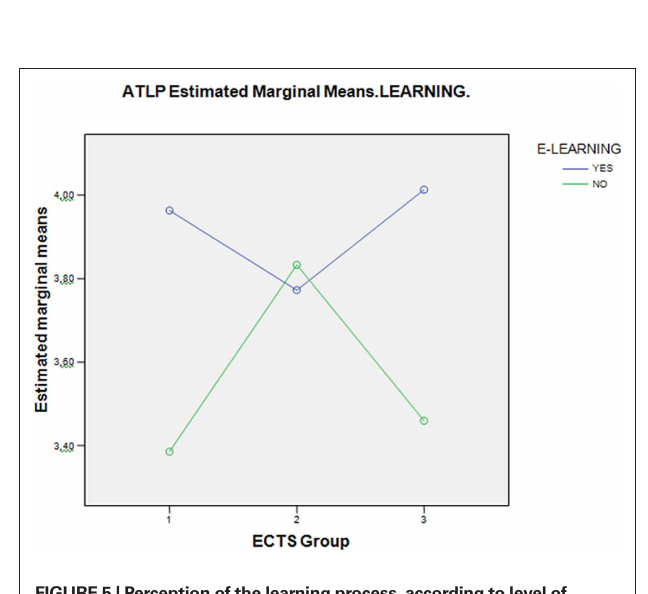
FIguRE 4 | Perception of the teaching process, according to level of performance, in class subjects with and without use of e-learning.